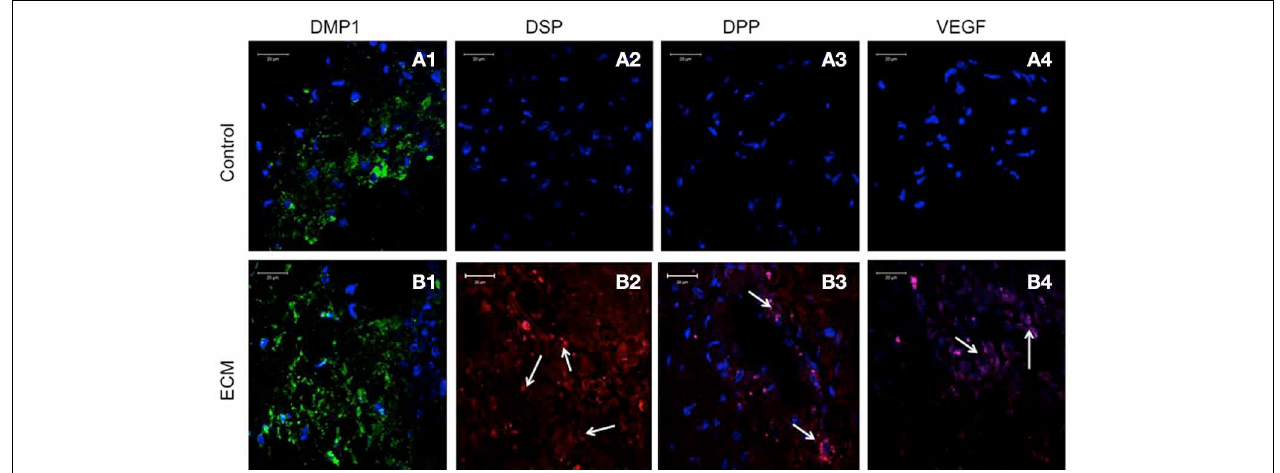
FIGURE 6 | PDLSC immunohistochemistry. The fluorescent images are representative confocal micrographs of sections from PDLSC seeded scaffold explants consisting of control collagen/chitosan scaffold (A) and pulp ECM scaffold (B) . The sections were analyzed for the expression of DMP1 (A1,B1) , DSP (A2,B2) , DPP (A3,B3) , and VEGF (A4,B4) . Note